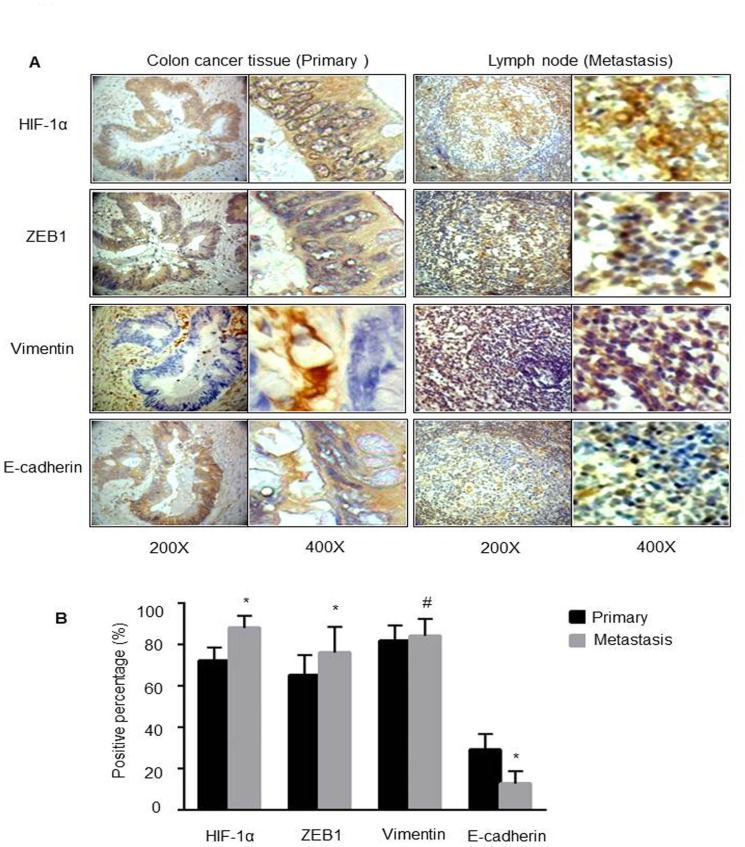
Expression statuses of HIF-1α, ZEB1, Vimentin and E-cadherin in tissue specimens.Representative images of IHC (A) and quantification of positive tumor cells (B) in both primary CRC specimens and the according metastatic lymph node. Original magnification, 200X. *P < 0.05 and #
P > 0.05.